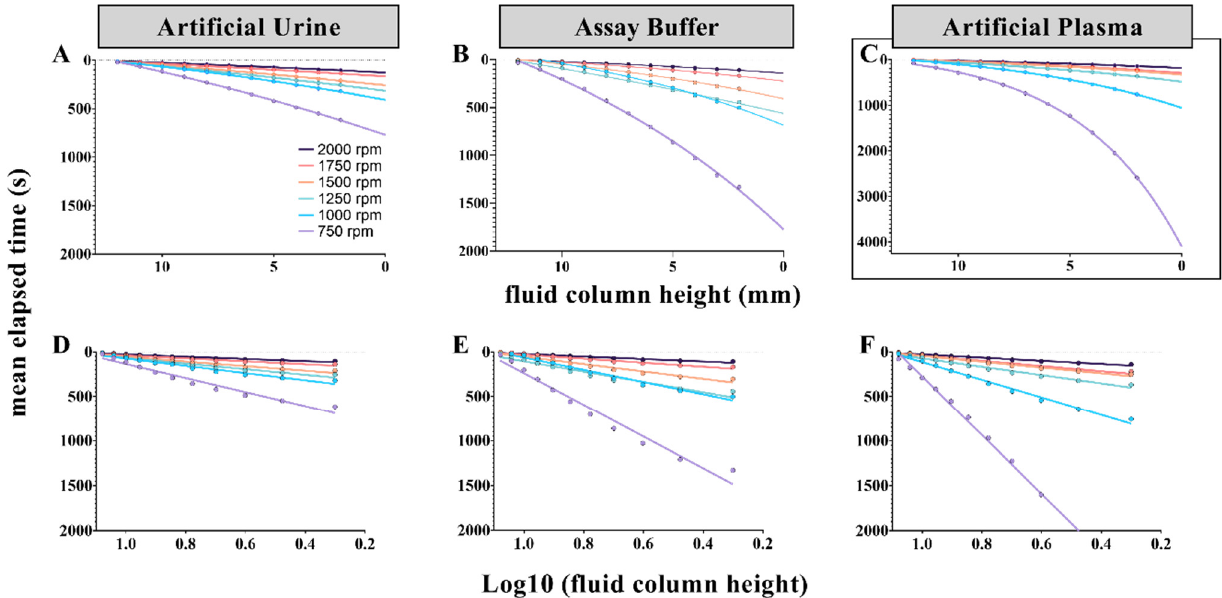
Figure 4. Exponential decay curves depicting the remaining fluid column height in the sample chamber ( ∆ r ) as a function of elapsed time. To assess the impact of differing aqueous sample matrices, 4 mm cutouts of BioRAD 0.2 µ m pore size membranes were embedded into each cOF disc. Aliquots of each sample solution (200 µ L volumes of artificial urine, assay buffer, and artificial blood plasma) were loaded into the sample chambers (Figure 1 inset). Rotational frequency (rpm) was held constant for each fluid drainage trial (n = 4 for each fluid type-rpm pairing). Note: Y-axis for plot C is larger to capture the full extent of the 750 rpm trials. Plots ( A – C ) depict mean elapsed time (s) vs. the remaining fluid column height in the sample chamber (mm). Plots ( D – F ) demonstrate how those exponential decay curves can be linearized via semilog transformation, i.e., x-axis was transformed to Log10 of the remaining fluid column height.